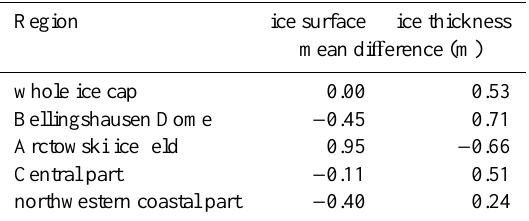
Table 1. Vertical accuracy of the grids (ice surface and ice thick- ness) and regional variations. The di ff erence between gridded and original data is calculated by subtracting the grid value from the original value.